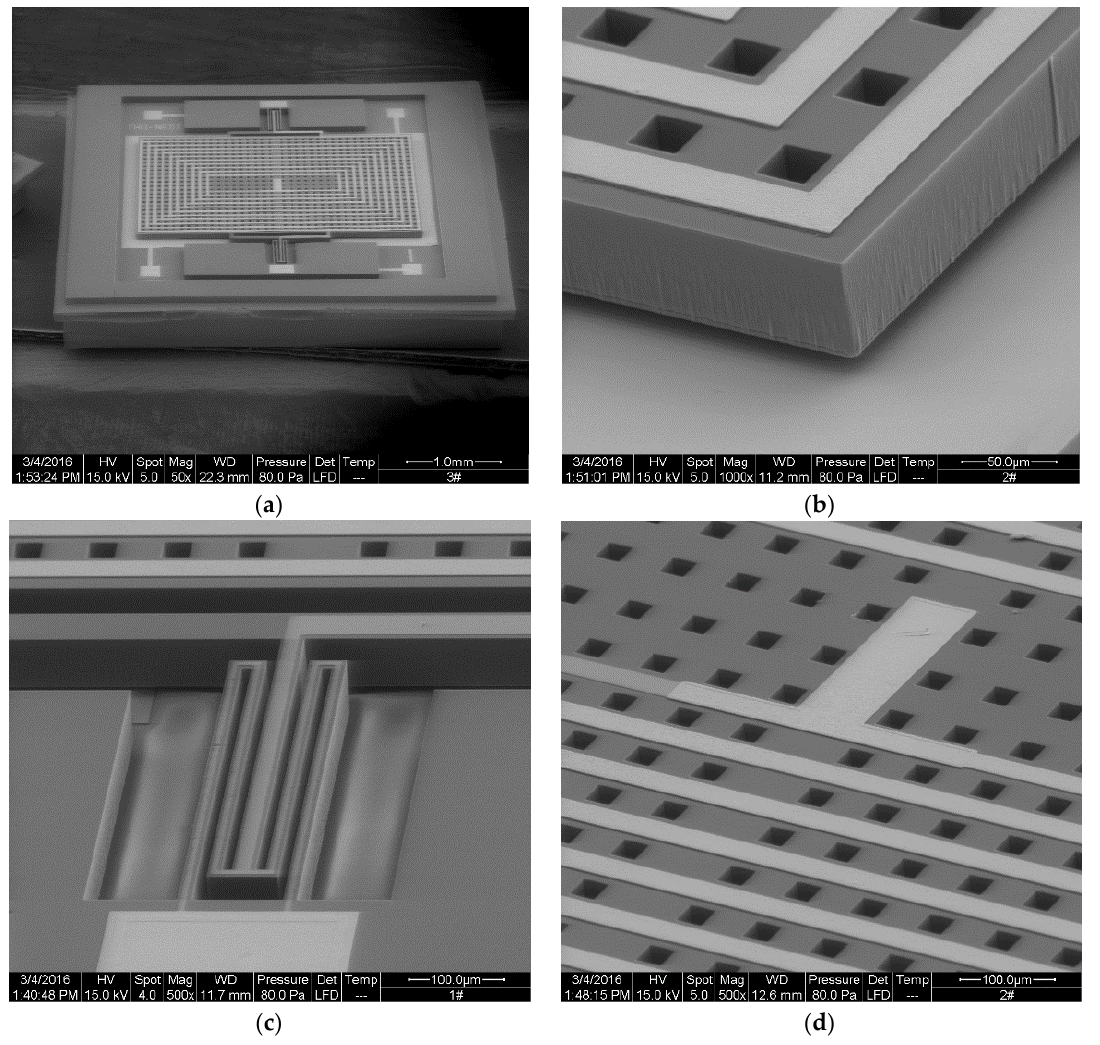
Figure 2. ( a ) MEMS structure of the device; ( b ) partial enlargement of the gap between pendulum and lower plate; ( c ) partial enlargement of the torsion beam; ( d ) partial enlargement of the pendulum. Table 2. Main parameters of MEMS magnetometer structure.